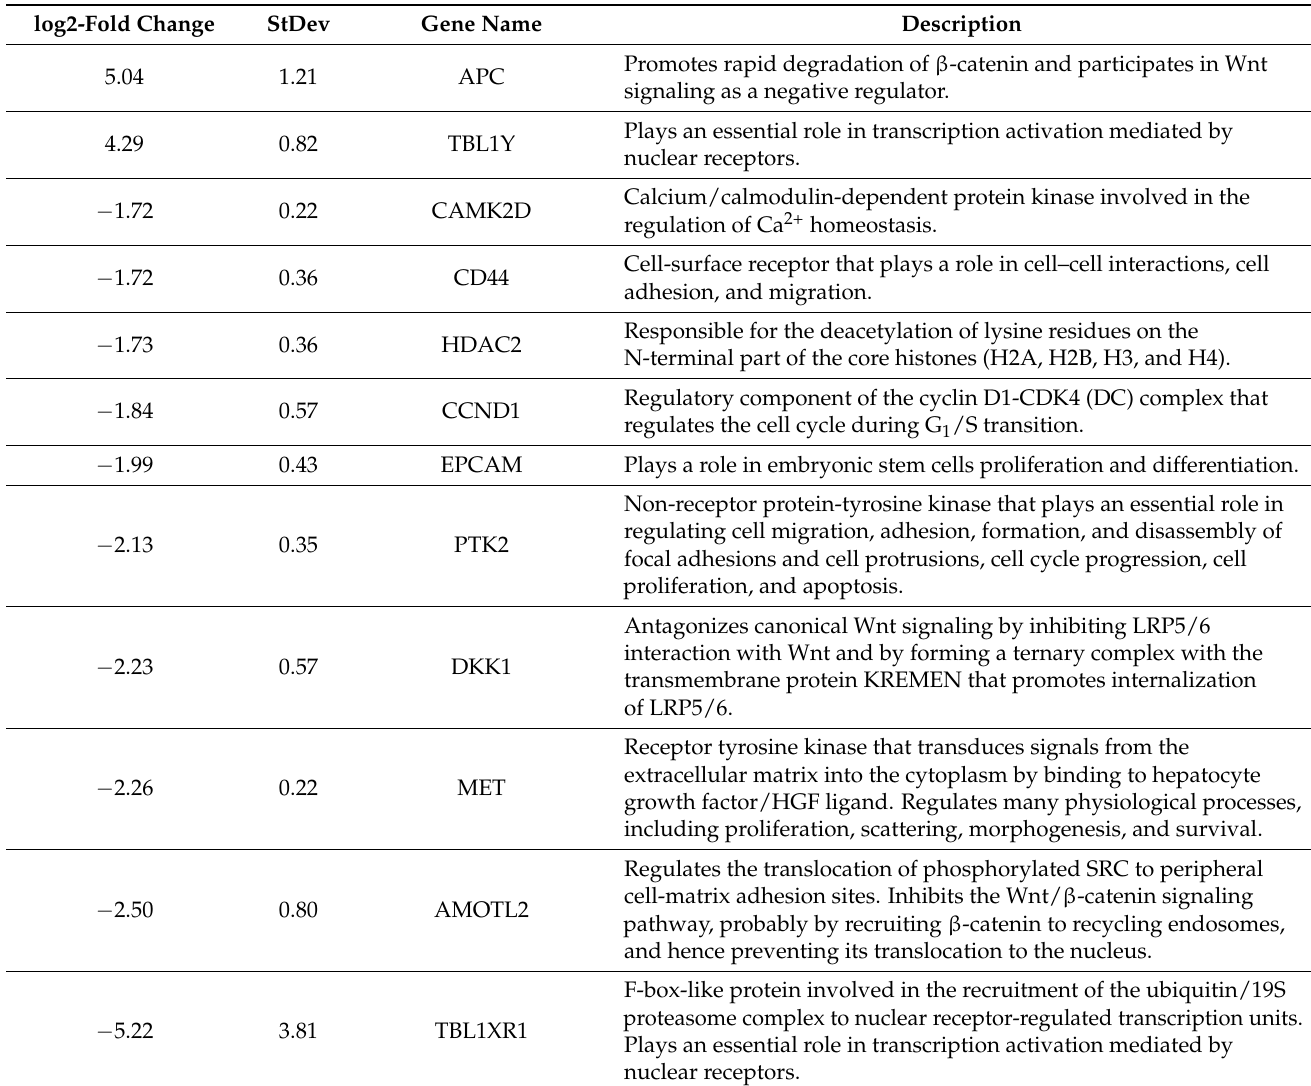
Table A1. List of differentially expressed Wnt signaling pathway-related factors or target genes